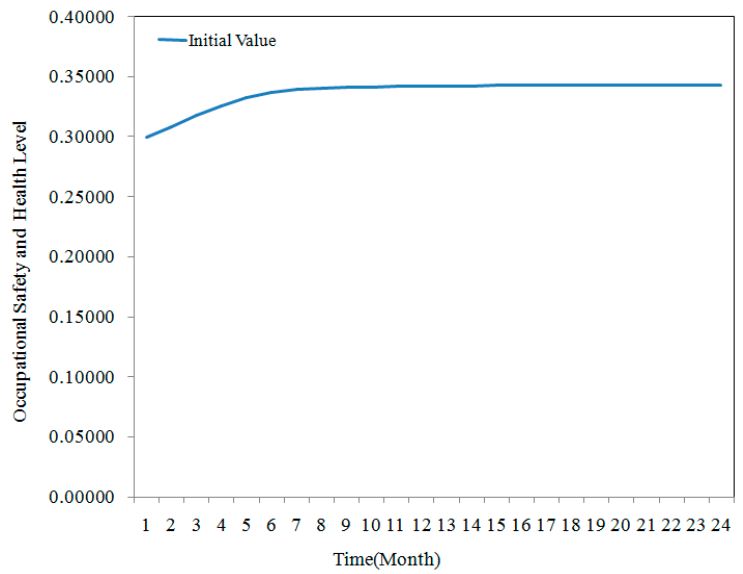
Figure 5. OSH level initial state SD simulation.